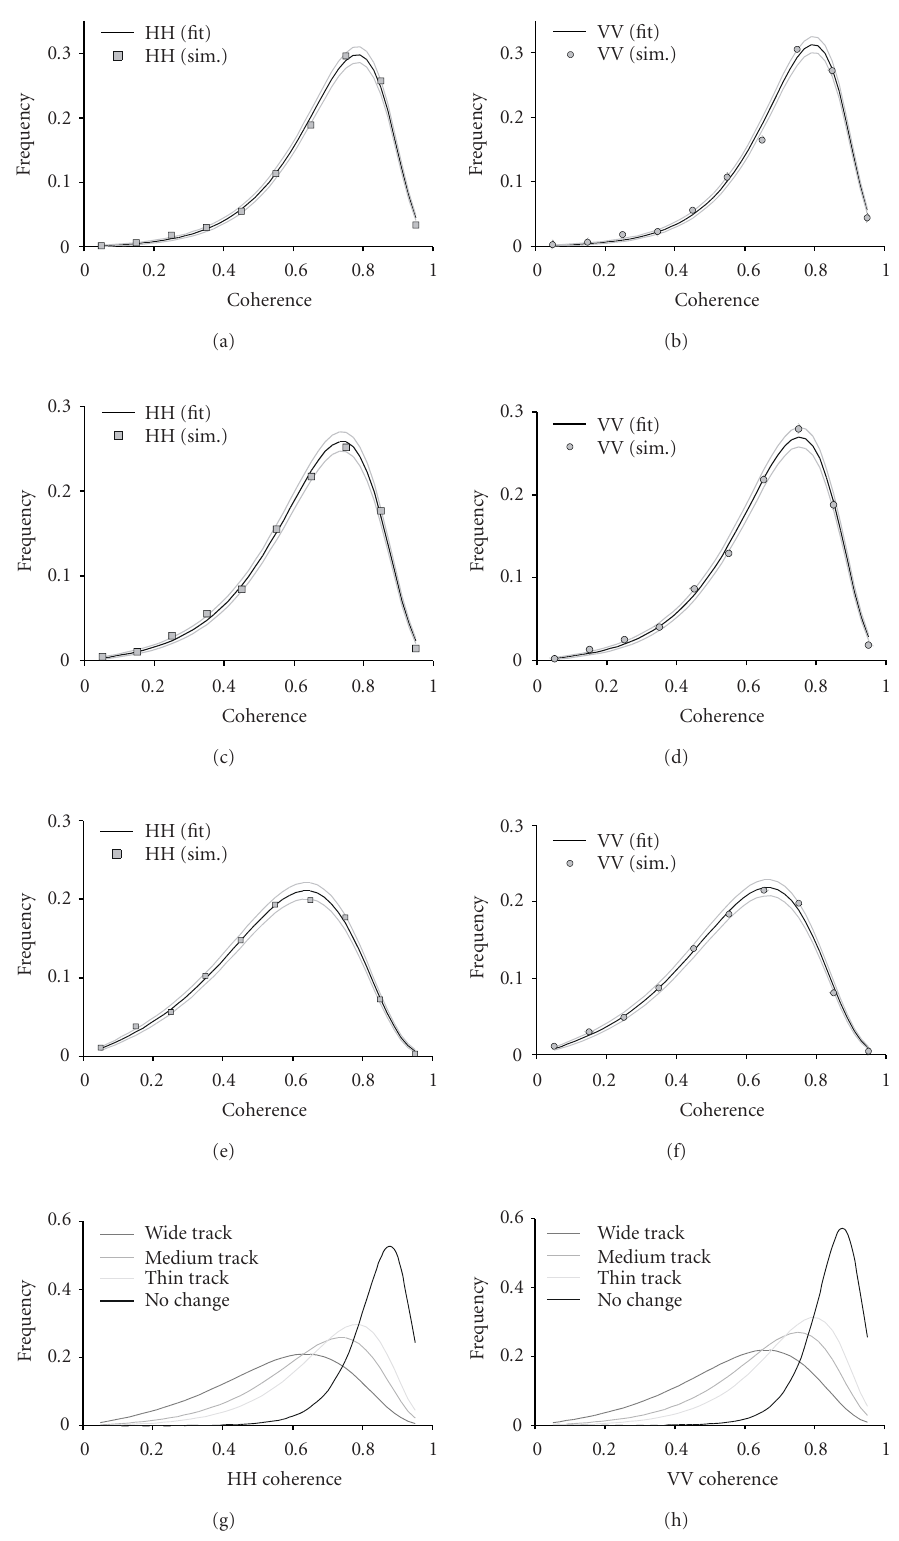
Figure 5: Coherency estimate histograms for (a), (b) thin track, (c), (d) medium track, and (e), (f) wide track. HH on the left and VV on the right. (g), (h) The three fitted curves for each polarisation along with the distribution for the case of no change. In the first three rows, the light curves above and below the dark curve indicate the expected standard